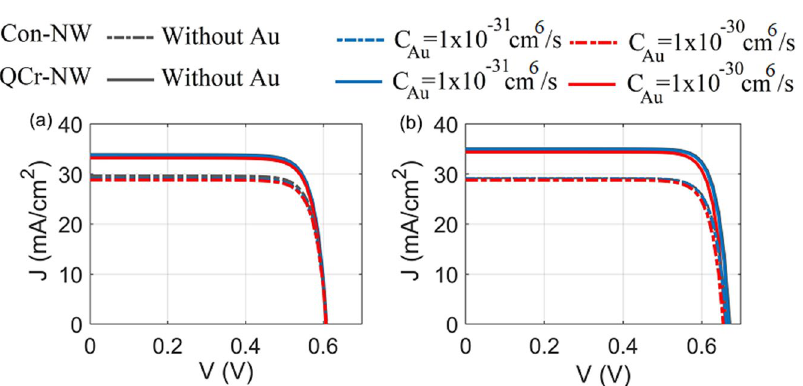
Figure 13. J–V characteristics under different Auger coefficient for the studied designs in the ( a ) axial and ( b ) core–shell